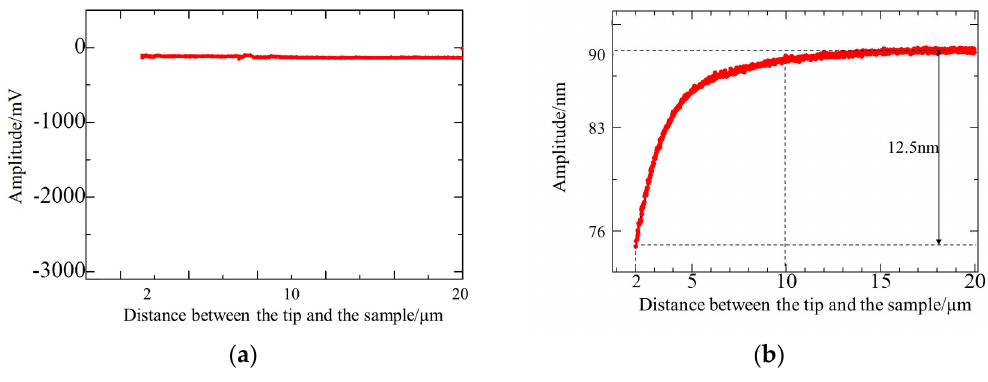
Figure 5. Approach curve of the 0.2 N/m cantilever ( a ) in contact mode ( b ) in tapping mode.